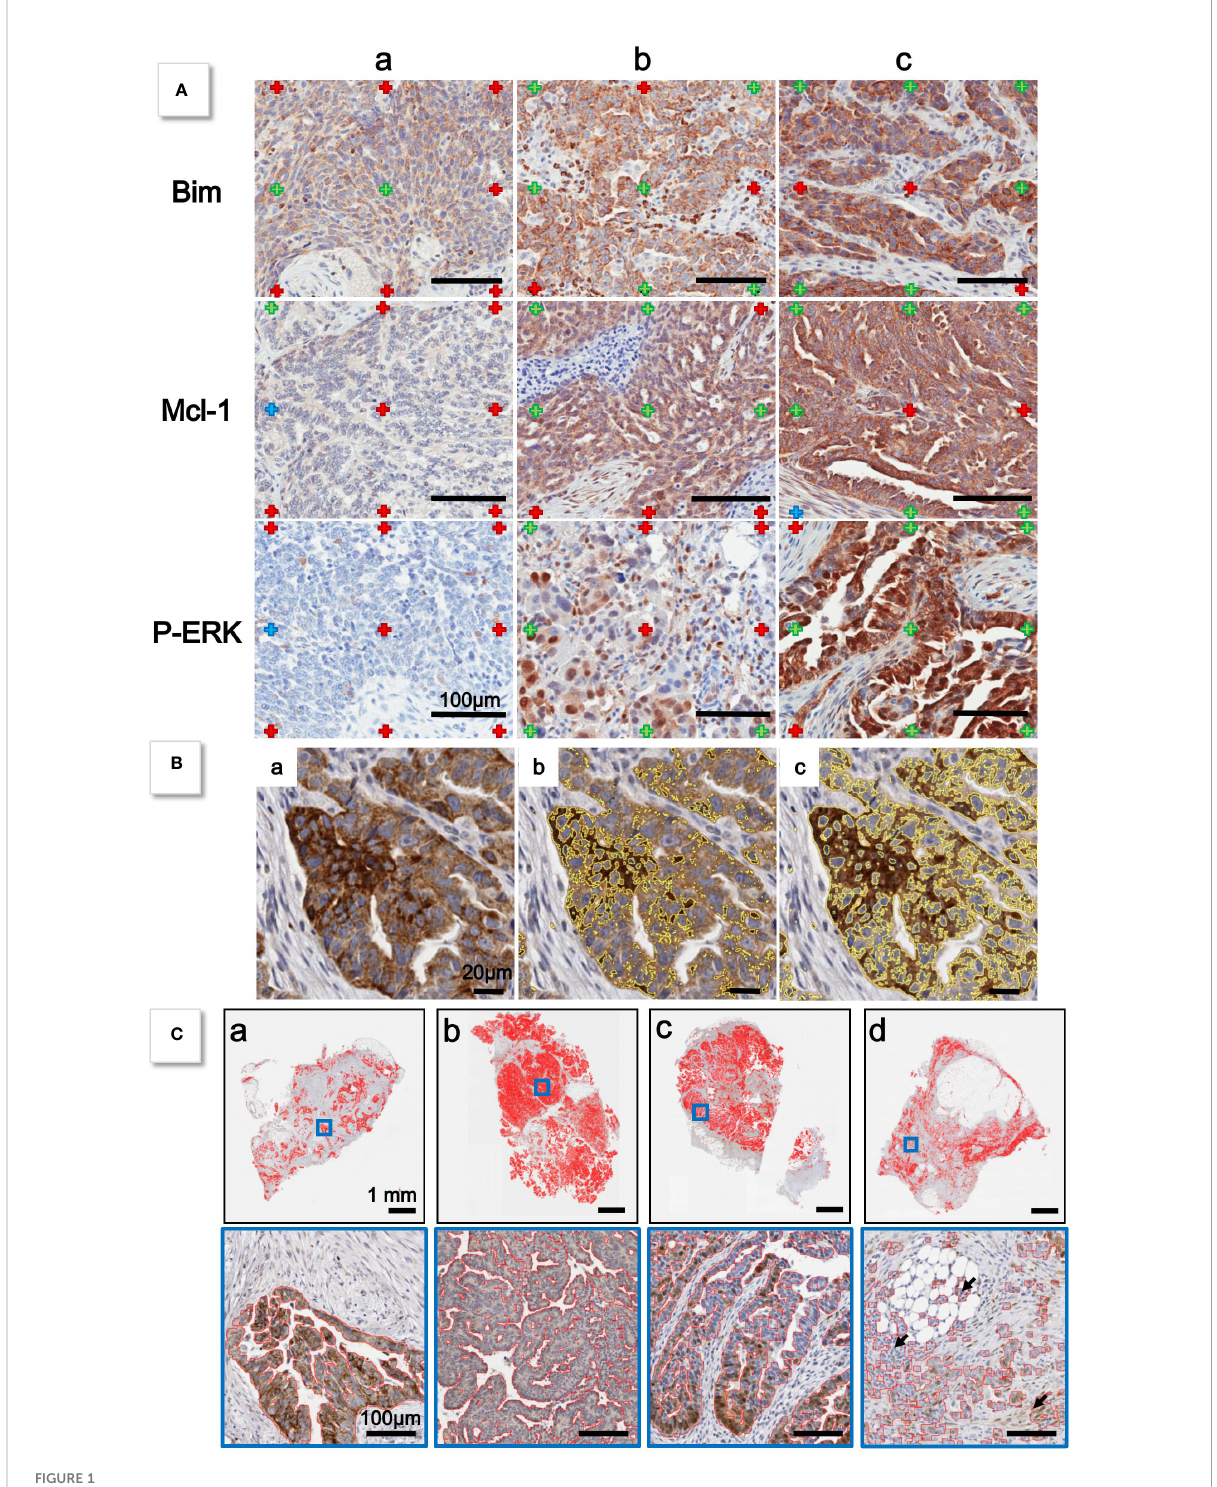
FIGURE 1 (A) Grid of cross is applied to histological sections. For each marker, a selection of sections is made to evaluate low (a) , medium (b) , and high (c) intensity staining. For each cross, expert indicates if labeled (green cross) or unlabeled (red cross) staining. (B) Detail of (a) histological section. Yellow lines indicate limits of detection of Otha method before calibration (b) and after calibration (c) . (C) Examples of epithelium detection after calibration by Gabor method (red